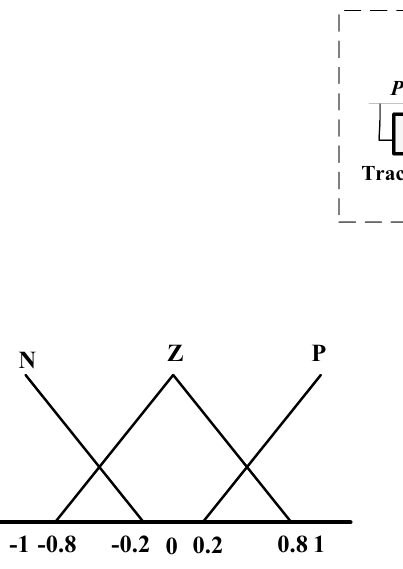
Fig. 7 MFs of the speed error for type-1 fuzzy